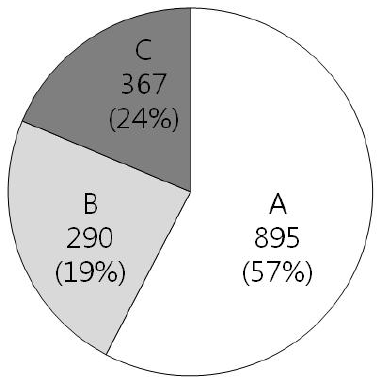
Figure 1. Genomic composition of H. pylori strain 29965 (total 1,552 ORFs). A includes genes which have orthologs of known function, B include genes which have orthologs of unknown function, and C includes H. pylori specific